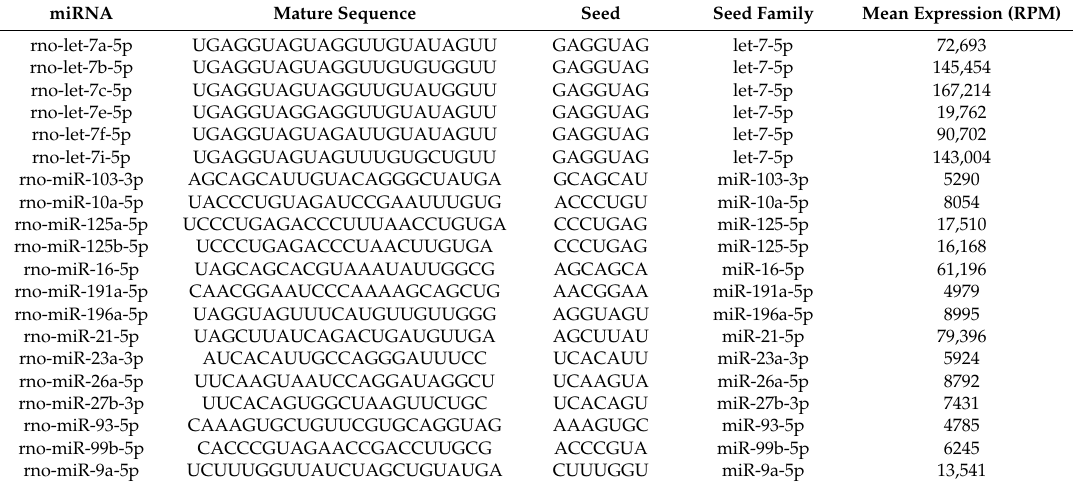
Table 1. The 20 miRNAs highest expressed in EVs derived from WT rat primary Schwann cells. RPM stands for reads per million mapped reads.